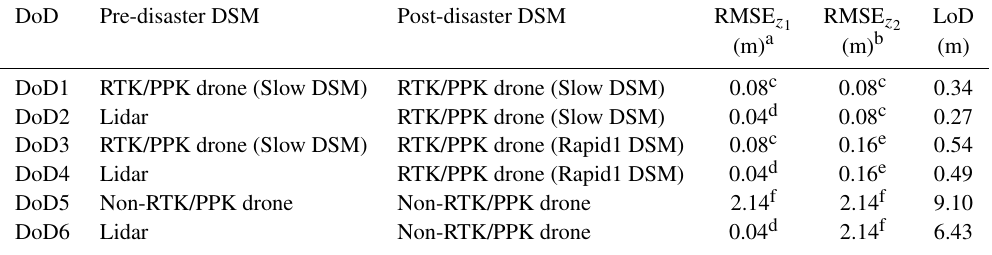
Table 2. Hypothetical DoDs calculated using different DSM combinations. The LoD for each DoD was calculated using Eq.